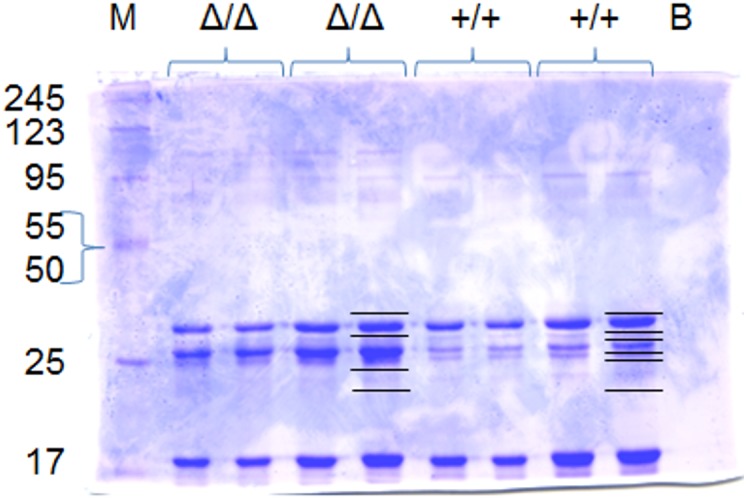
SDS-PAGE of crude mare’s milk being homozygous for the deletion (Δ/Δ) and homozygous for the long variant (+/+).Ten and 20 μg of crude milk from both mares was loaded in duplicate. Excised bands that were in-gel digested with trypsin and later analyzed by LC-MS are indicated. M (Roti®-Mark Bicolor protein standard); B (Blank, Laemmli buffer).